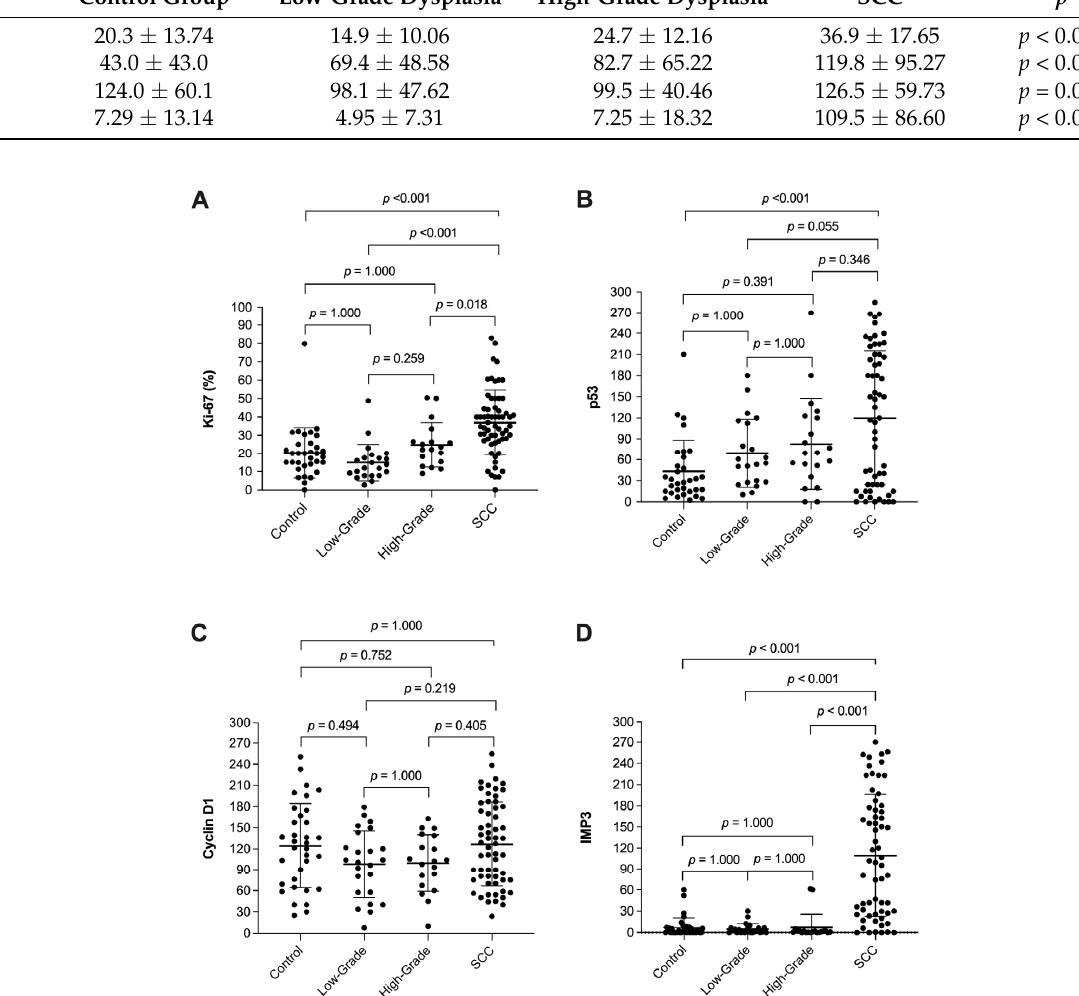
Figure 1. Box plots for post hoc comparison: Plots are indicated as mean ± SD. They show the expression of Ki-67 ( A ), p53 ( B ), cyclin D1 ( C ), and IMP3 ( D ) proteins in laryngeal lesions.